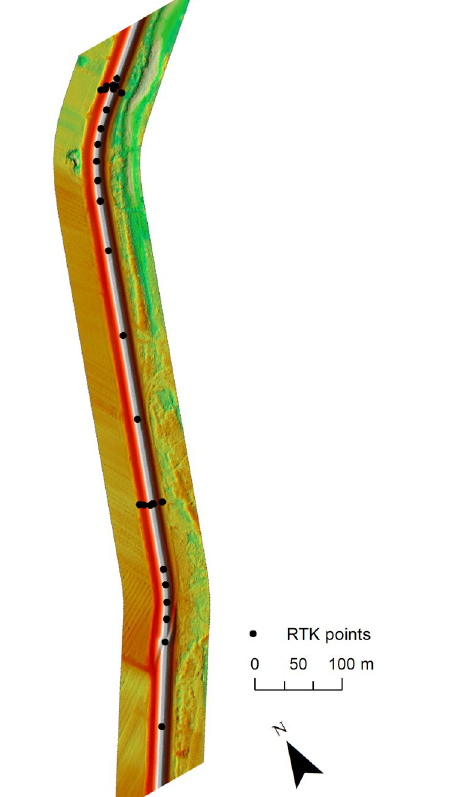
Fig. 5. The example of distribution for cross-section with unsignalised check points overlaying with color-coded digital terrain model